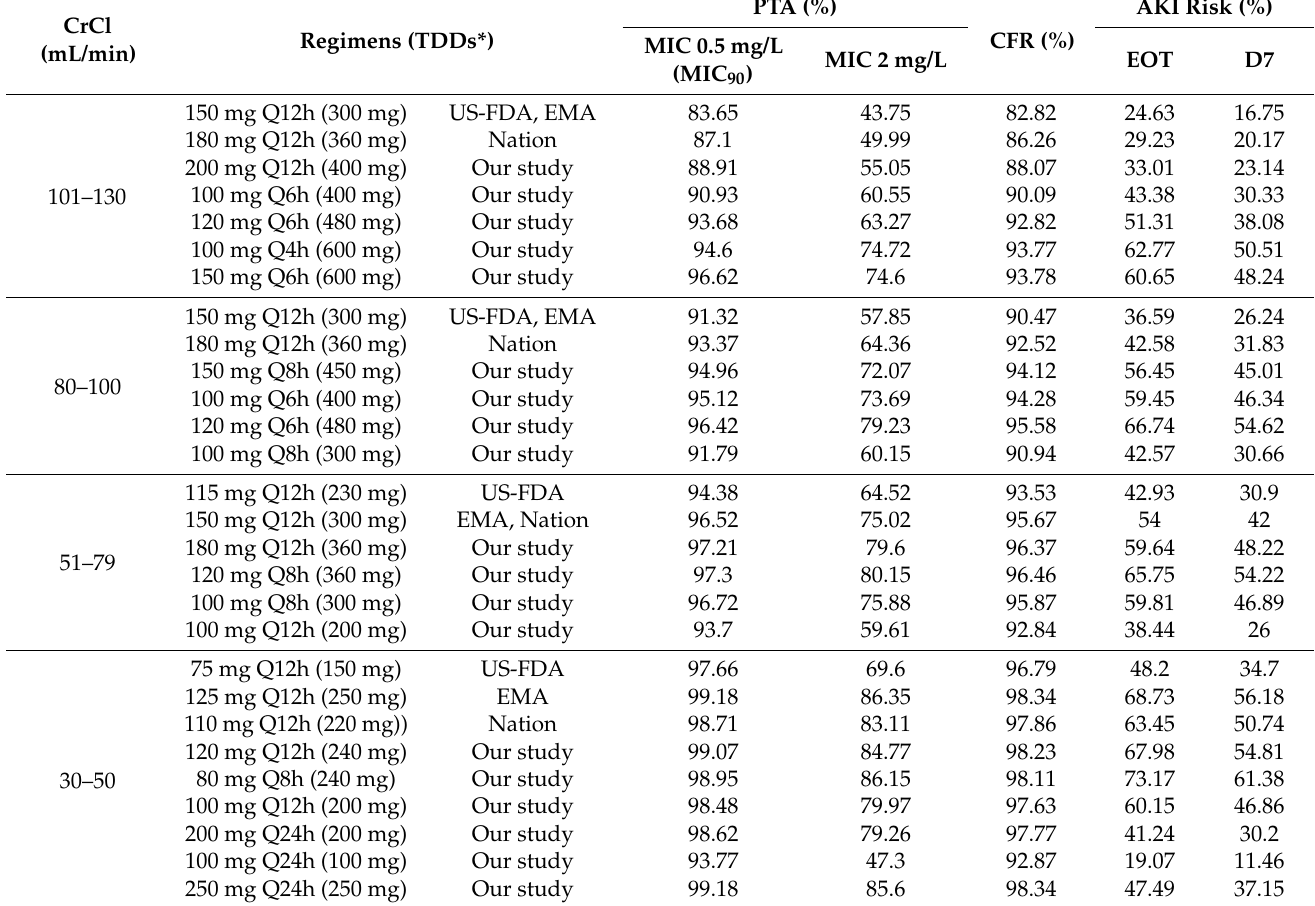
Table 4. PTA, CFR and AKI risk of simulated regimens from US-FDA, EMA, Nation, and our study.